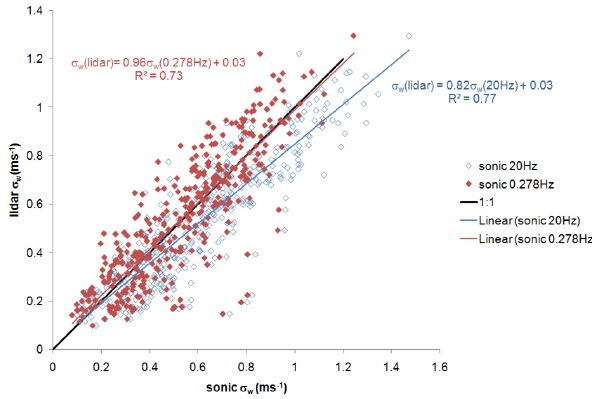
Fig. 3. Scatterplot of standard deviation of vertical velocity σ w Figure 3. Scatterplot of standard deviation of vertical velocity w measured by lidar against measured by lidar against sonic anemometer σ w sampled at 20Hz sonic anemometer w sampled at 20 Hz and averaged to 0.278 Hz. and averaged to